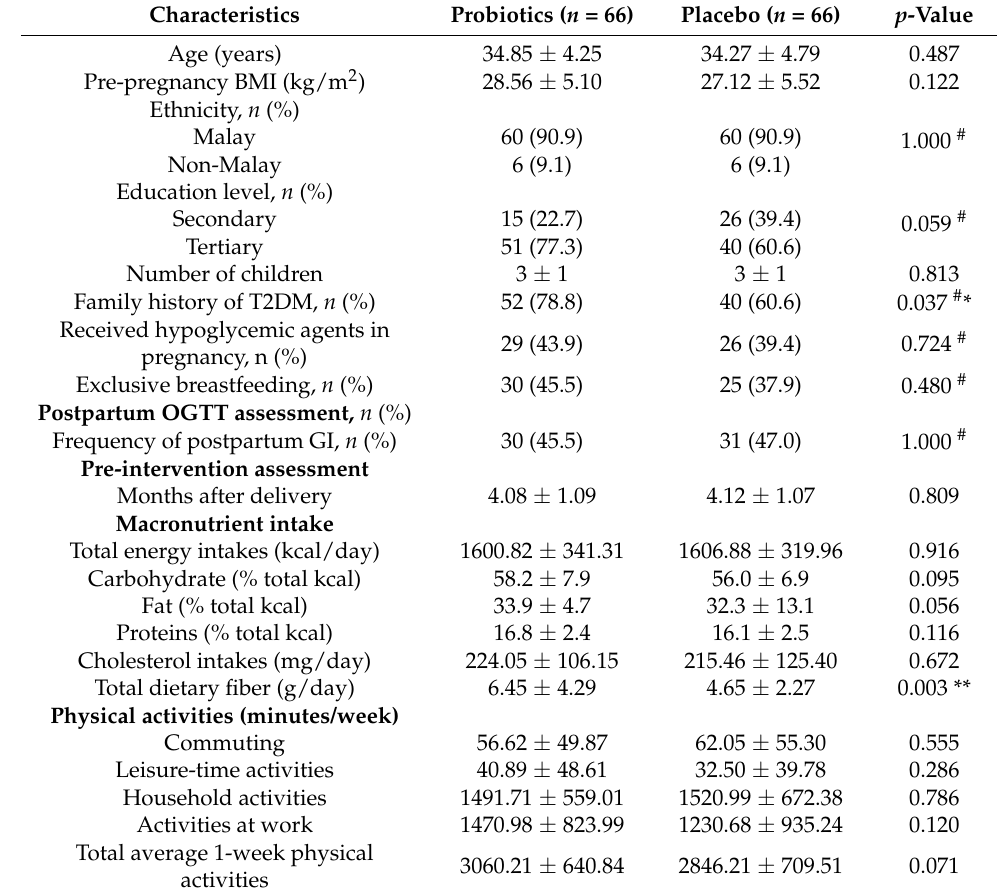
Table 1. Baseline characteristics of the participants categorized into probiotics and placebo groups.